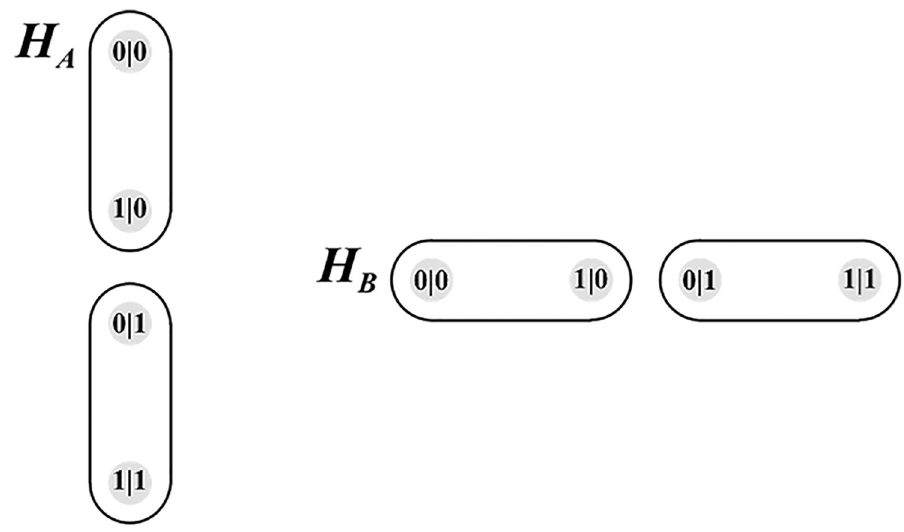
Fig 3. Hypergraph Representation Of EPR Systems A &